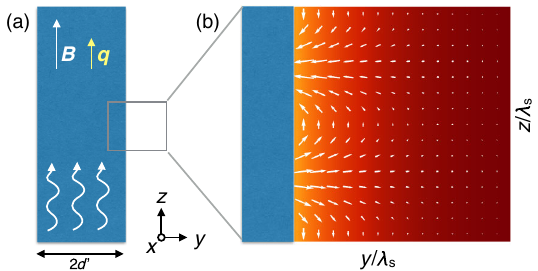
FIG. 8. Proposed geometry for the EM-field emission meas- urement in the limit when all the dimensions of the crystal are much larger than the sound wavelength λ . (a) A slab of thickness s d ¼ 2 d 0 is subjected to magnetic field B and a longitudinal acoustic sound wave propagating along the z direction. (b) A snapshot of the electric-field distribution near the surface calcu- lated from Eq. (4.22). As a function of time, the entire pattern moves in the z direction at the speed of sound c s